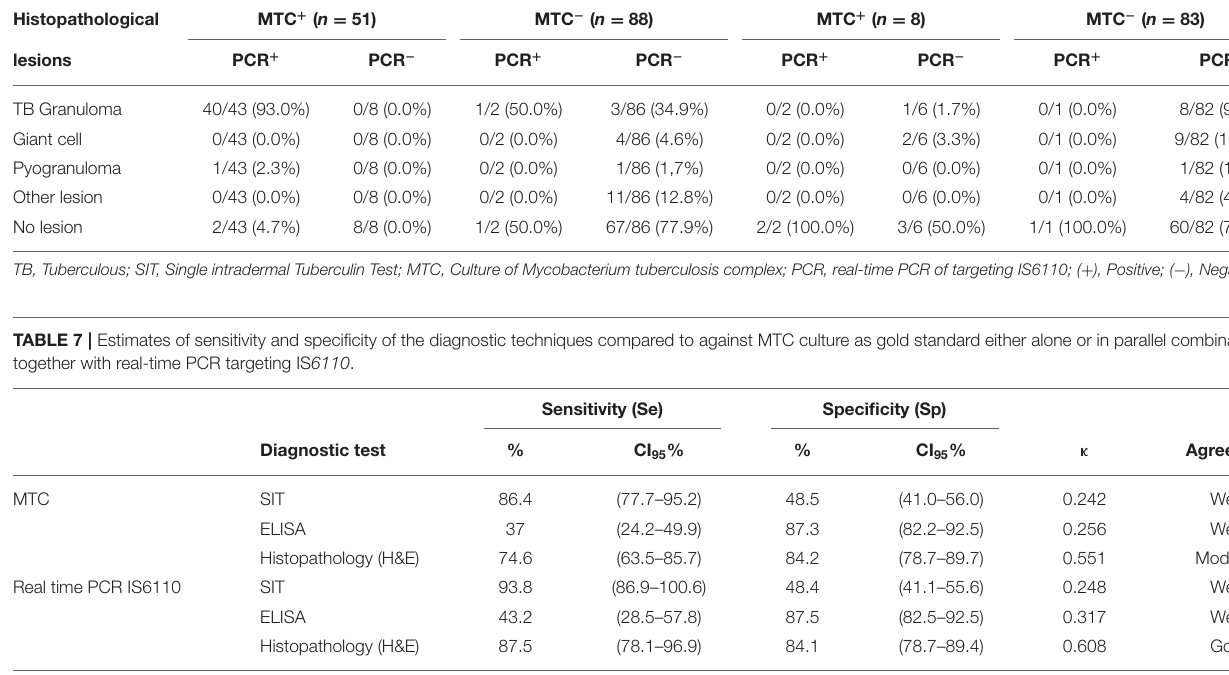
TABLE 6 | Distribution of the results collected from the 230 animals which were positive or negative to single intradermal skin test and subclassified by culture of MTC and real-time PCR targeting IS 6110 vs. histopathological lesions. SIT + ( n = 139) SIT − ( n = 91) Histopathological